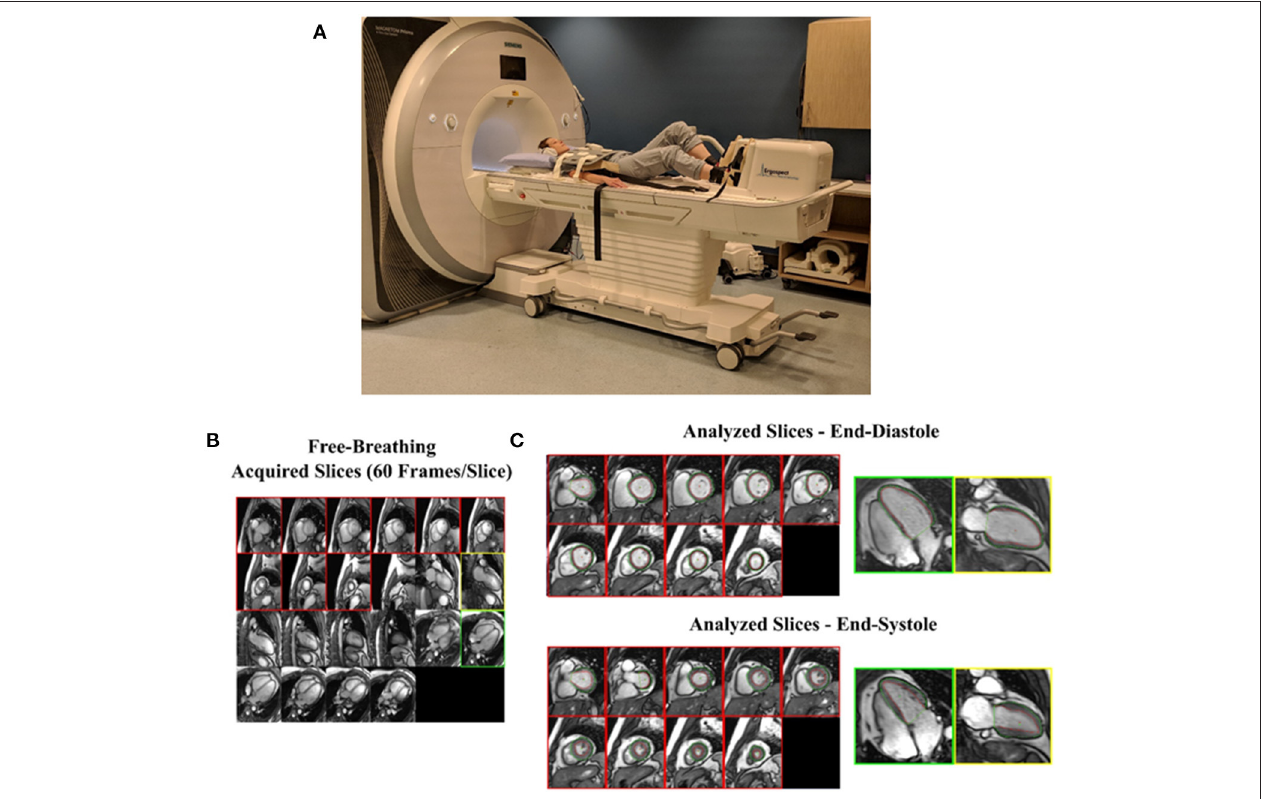
FIGURE 2 | Real-time imaging of cardiac function during exercise using cardiac MRI. (A) Healthy volunteer in supine position outside of magnet bore using MRI conditional stepper device to achieve maximal aerobic activity. (B) All short-axis and long-axis slices are viewed simultaneously to select those for volumetric analysis. Short-axis slices with myocardium and a single 2- and 4-chamber view are chosen. (C) A full cardiac cycle for each selected slice is extracted from which end-diastolic and end-systolic images are identified and endocardial (red) and epicardial (green) borders are traced. Modified from Kirkham et al. ( 97).